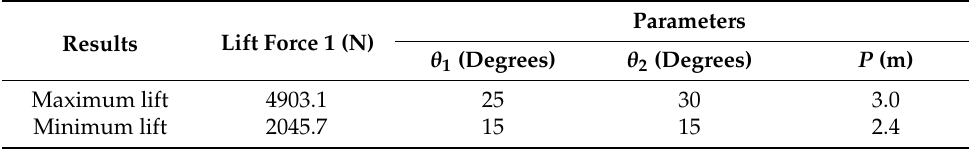
Table 4. Maximum and minimum values of the parameters for case